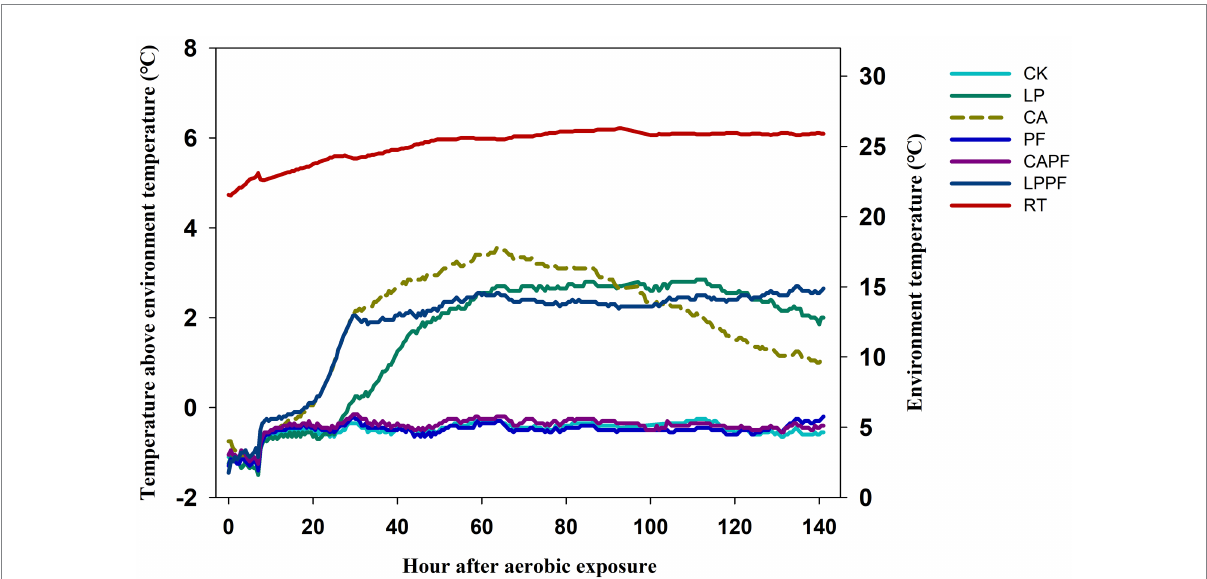
FIGURE 1 Temperature after aerobic exposure of forage oat silages treated additives. CK, control; LP, Lactobacillus plantarum a 214; CA, citric acid; PF, purple perilla; LPPF, purple perilla + Lactobacillus plantarum a214; CAPF, purple perilla + citric acid; RT, room